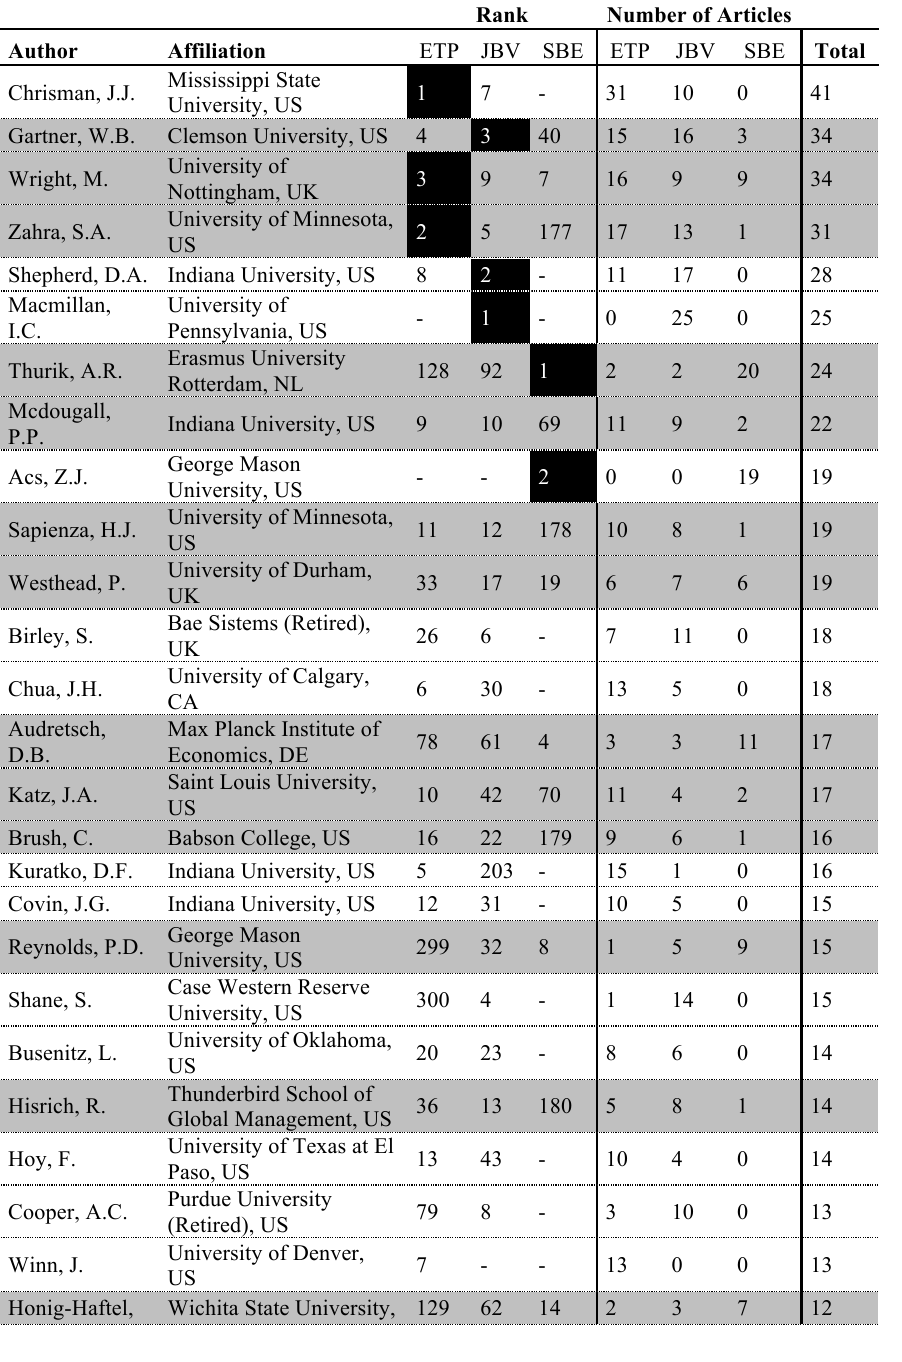
Table 1 : List of the top 20 most prolific authors in ETP, JBV and SBE Author